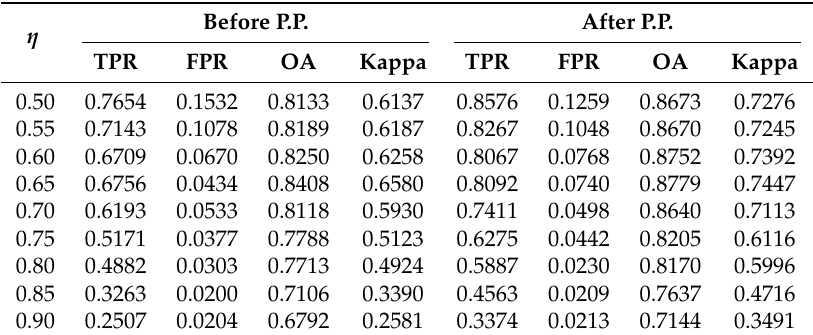
Table 4. Performances of the proposed method before and after post-processing for different η when n = 15 using the DigitalGlobe data.